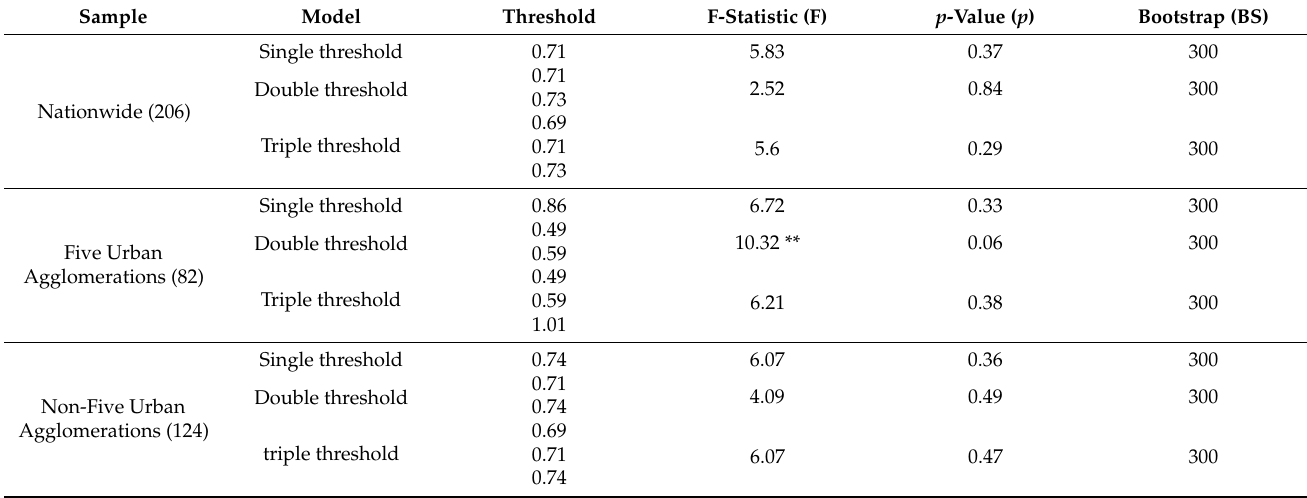
Table 5. Threshold effect test of environmental